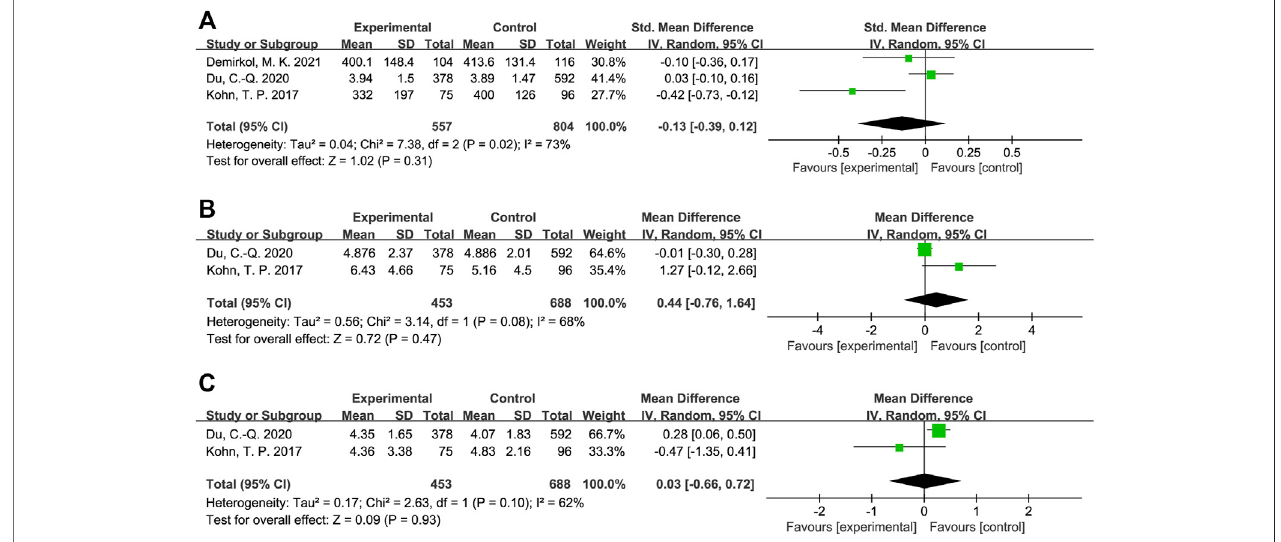
FIGURE 7 | Forest map evaluating the effects of sleep disorders on testosterone (A) , FSH (B) and LH (C) .